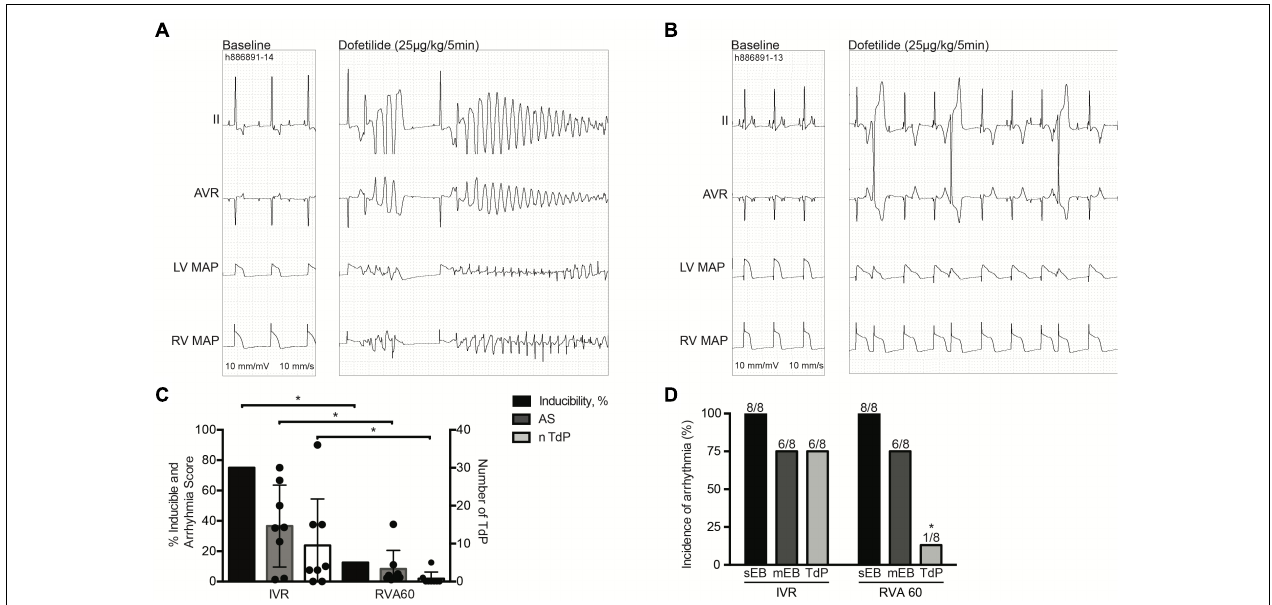
FIGURE 2 | Dofetilide experiments performed under IVR or RVA60 conditions in chronic atrioventricular block dogs. Representative ECG traces (lead II and AVR) associated with MAPs recorded from the LV and RV at baseline and after dofetilide (25 µ g/kg per 5 min) infusion in serial IVR (A) and RVA60 (B) experiments. Quantification of TdP-inducible CAVB dogs, AS, and average number of TdP. The circular dots represent the different experiments (C) . The incidence of sEB, mEB, and TdP under IVR and RVA60 conditions (D) . Values are represented as mean ± SD. AS, arrhythmia score; CAVB, chronic atrioventricular block; ECG, electrocardiogram; IVR, idioventricular rhythm; LV/RV MAP, left/right ventricular monophasic action potential; mEB, multiple ectopic beat; RVA60, right ventricular apex paced at 60 beats per minute; sEB, single ectopic beat; TdP, torsade de pointes arrhythmia. * p < 0.05 vs.